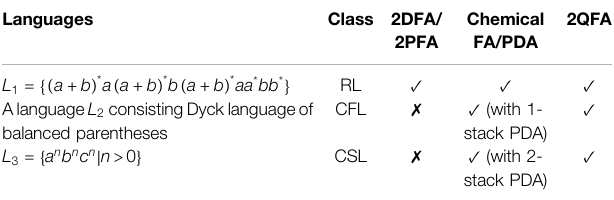
TABLE 3 | Comparison of computational power of models.